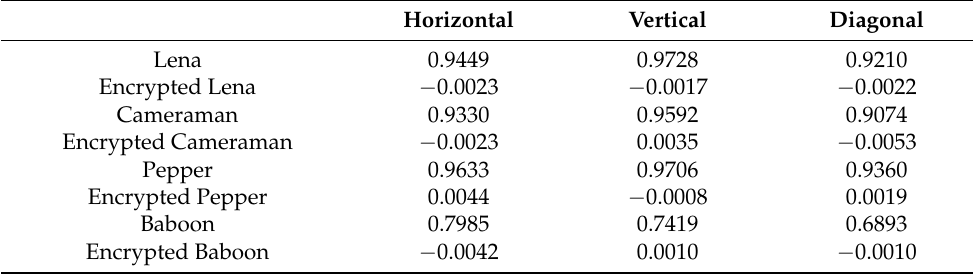
Table 1. Correlation coefficients of different images.